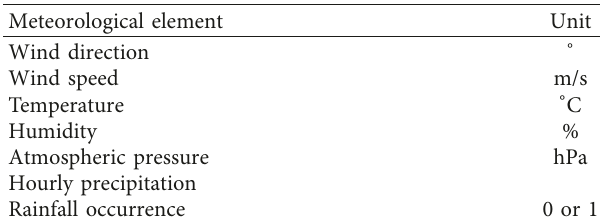
Figure 1: Locations of the 572 automatic weather stations (AWSs) in South Korea [18]. Table 1: Meteorological elements in automatic weather station (AWS)